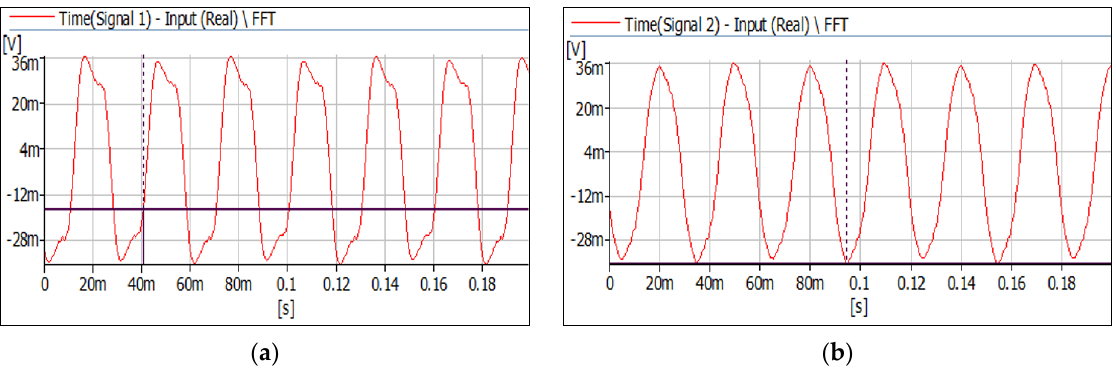
Figure 19. Signals measured by the flux sensors for unbalanced load: ( a ) emf measured in position 1, ( b ) emf measured in position 2.